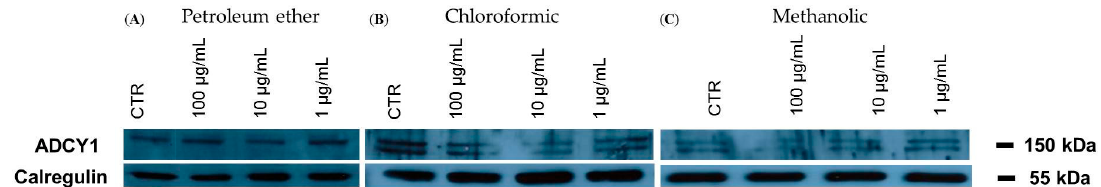
Figure 3. Representative Western blot of adenylate cyclase 1 (ADCY1) protein in SH-SY5Y cells treated with petroleum ether ( A ); chloroform ( B ); and methanol ( C ) extracts of P. aculeata .